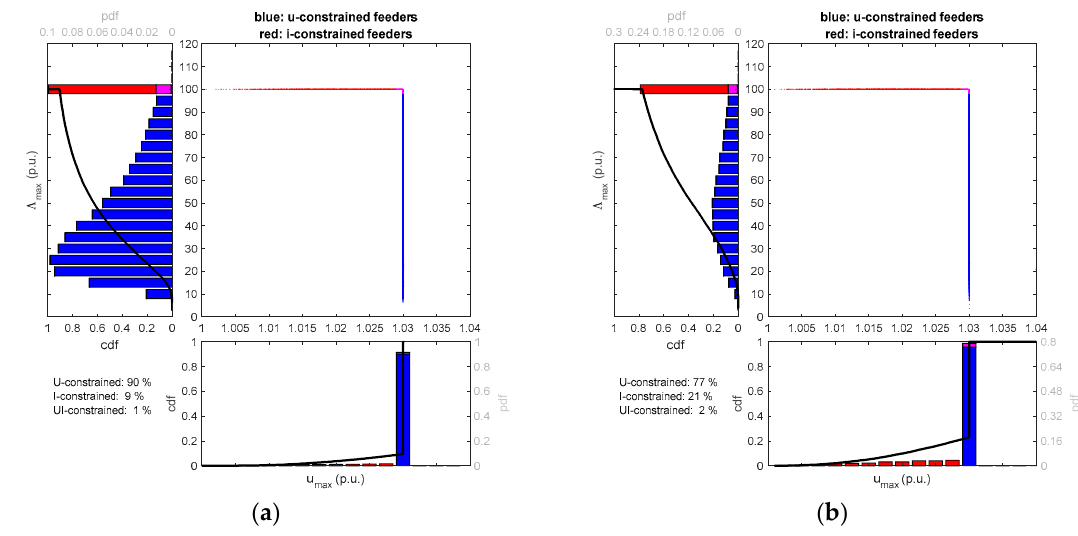
Figure 16. Voltage/current constraint assessment of feeders (red: loading constrained, blue: voltage constrained and purple: loading and voltage constrained) for: ( a ) DSO A; and ( b ) DSO B (colored according to the DER-scenario uniform and u max = 1.03 p.u. presented in [37]).